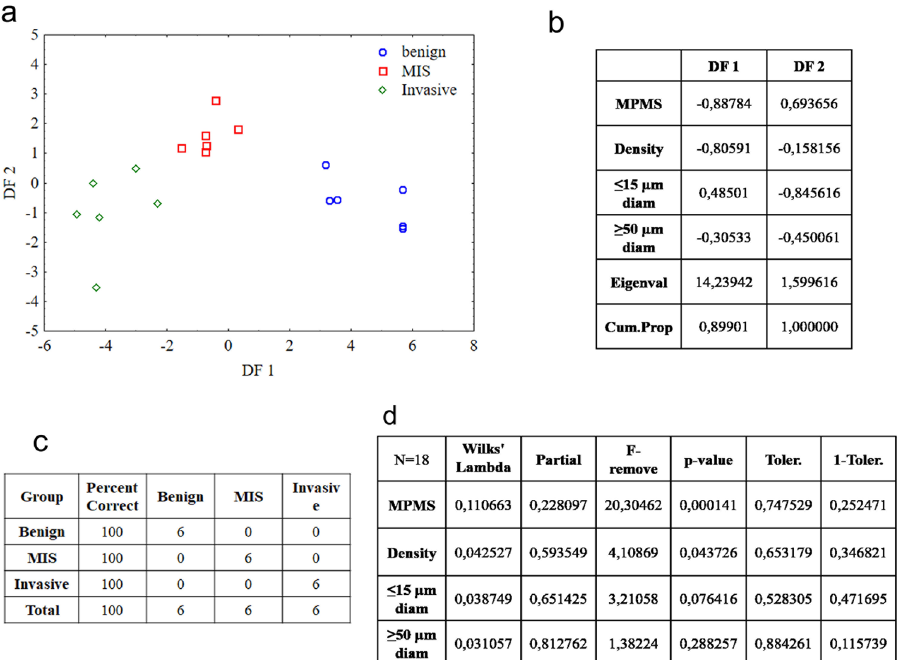
Figure 7. Discriminant function analysis of malignant features revealed in dermoscopic equivocal lesions. ( a ) Scatterplot represents discriminant functions (DF) distribution for benign lesions (blue cycle), melanoma in situ (red square) and invasive melanoma (green rhombus). ( b ) The standardized coefficients of discriminant functions DF 1 and DF 2. ( c ) Classification matrix. ( d ) Independent contributions to the